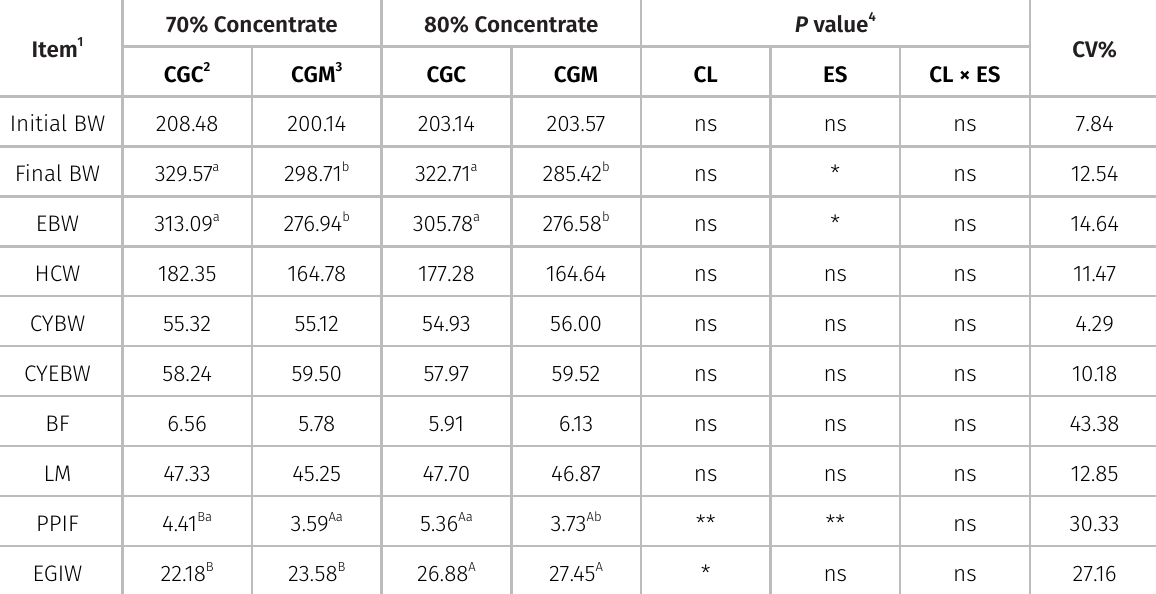
Table III. Feedlot performance, carcass and non-carcass traits of Nellore heifers fed two concentrate levels and energy